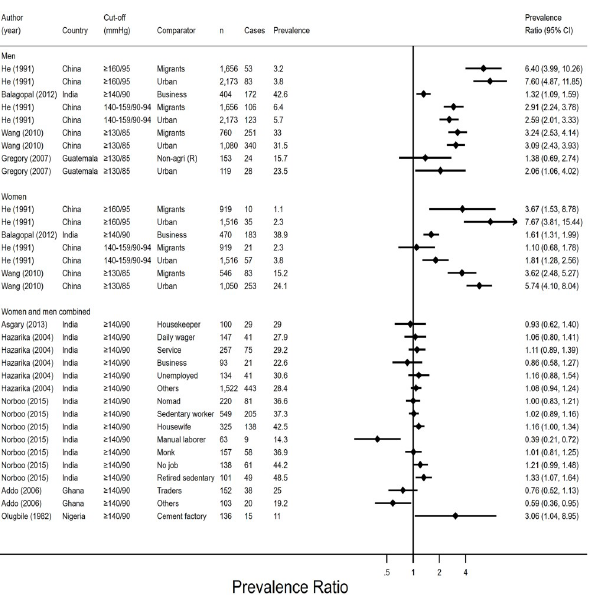
Fig 2. Prevalence ratios and 95% confidence intervals of hypertension by employment status (n = 9). Agri– agriculture, CI–confidence interval, n–sample size, PR–prevalence ratio, R–rural. Prevalence ratios were derived from comparing each non-agricultural group (coded 1) to the agricultural group (coded